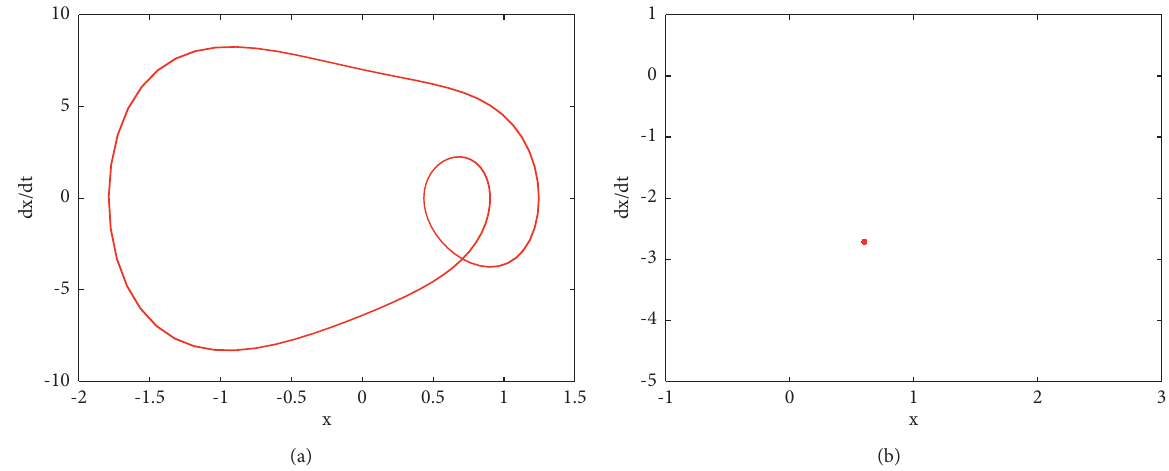
Figure 8: Phase portrait and Poincar´e cross section diagram of the system at F � 35 and τ � 1.2. (a) Phase portrait. (b) Poincar´e cross section diagram ( c � 0.5, c 1 � 30, c 2 � 20, μ � 0.001, k 1 � 10, and ω � 3.5).